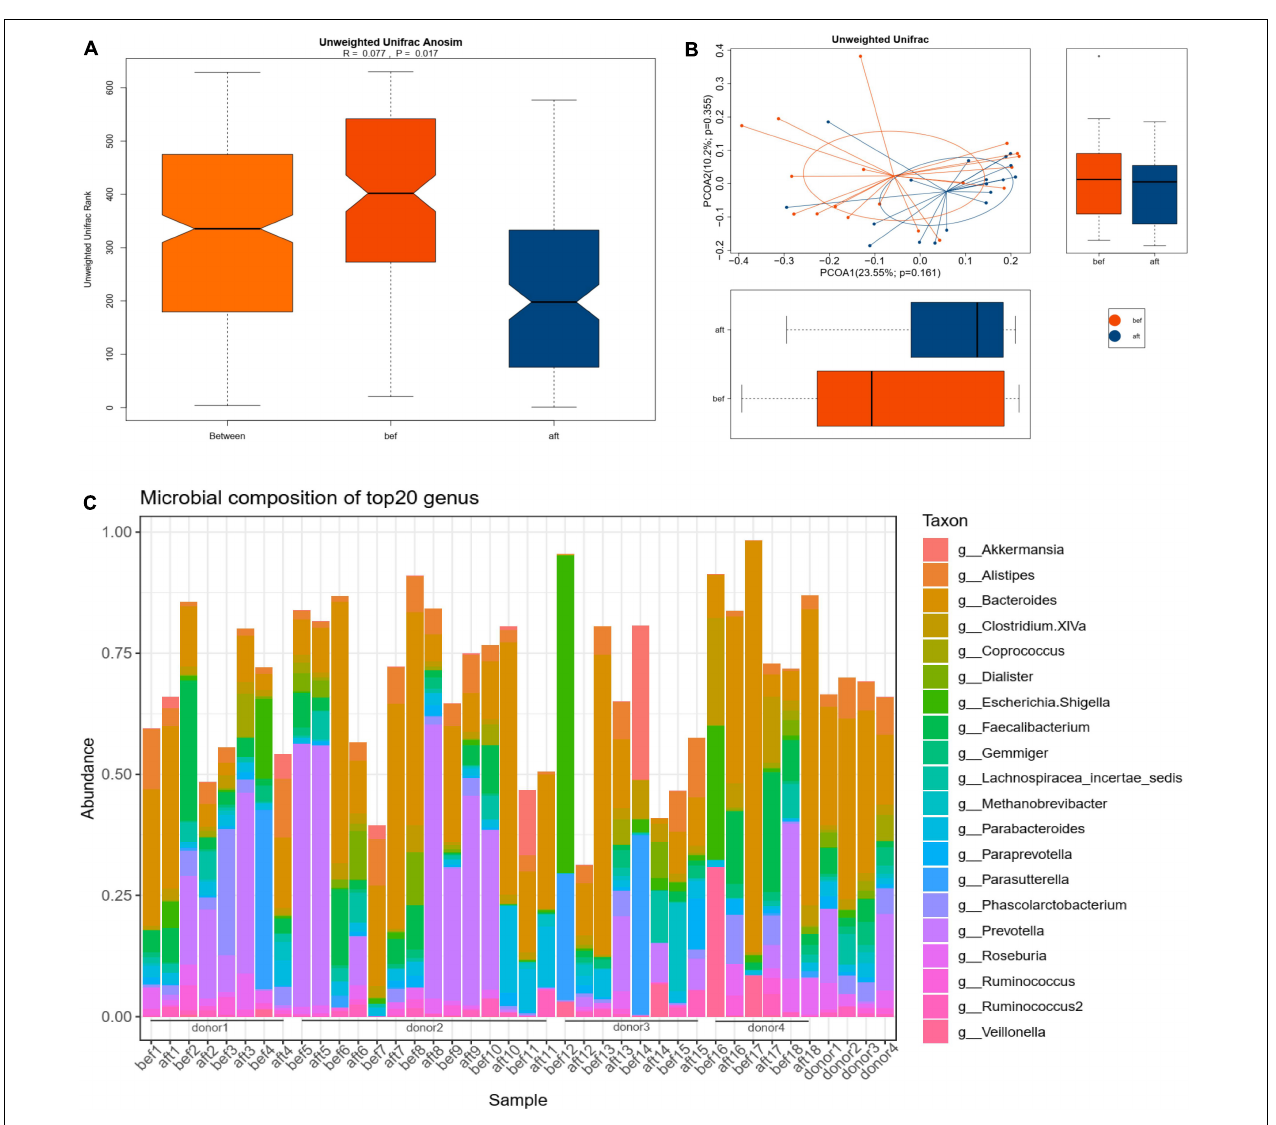
FIGURE 2 | Bacterial community compositions in pre-FMT and post-FMT fecal samples. “Bef” represents pre-FMT samples; “aft” represents post-FMT samples. (A) ANOSIM was used to determine the beta diversities of 18 patients’ gut microbiomes pre- and post-FMT. The bacterial community compositions differed significantly before and after FMT ( p = 0.017). (B) PCoA showed an overall shift in the 18 patients’ gut microbiota compositions after FMT. (C) Genus-level microbial compositions of the top 20 abundant taxa in patients’ and donors’ stool samples.